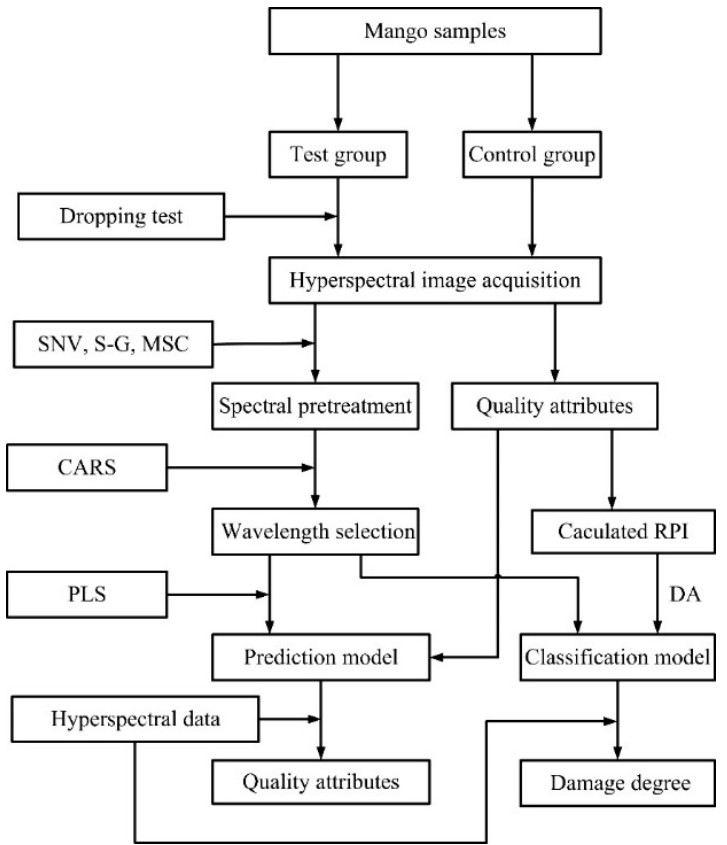
Figure 1. Flow chart of the process of evaluating mechanical damage to mango by HSI.